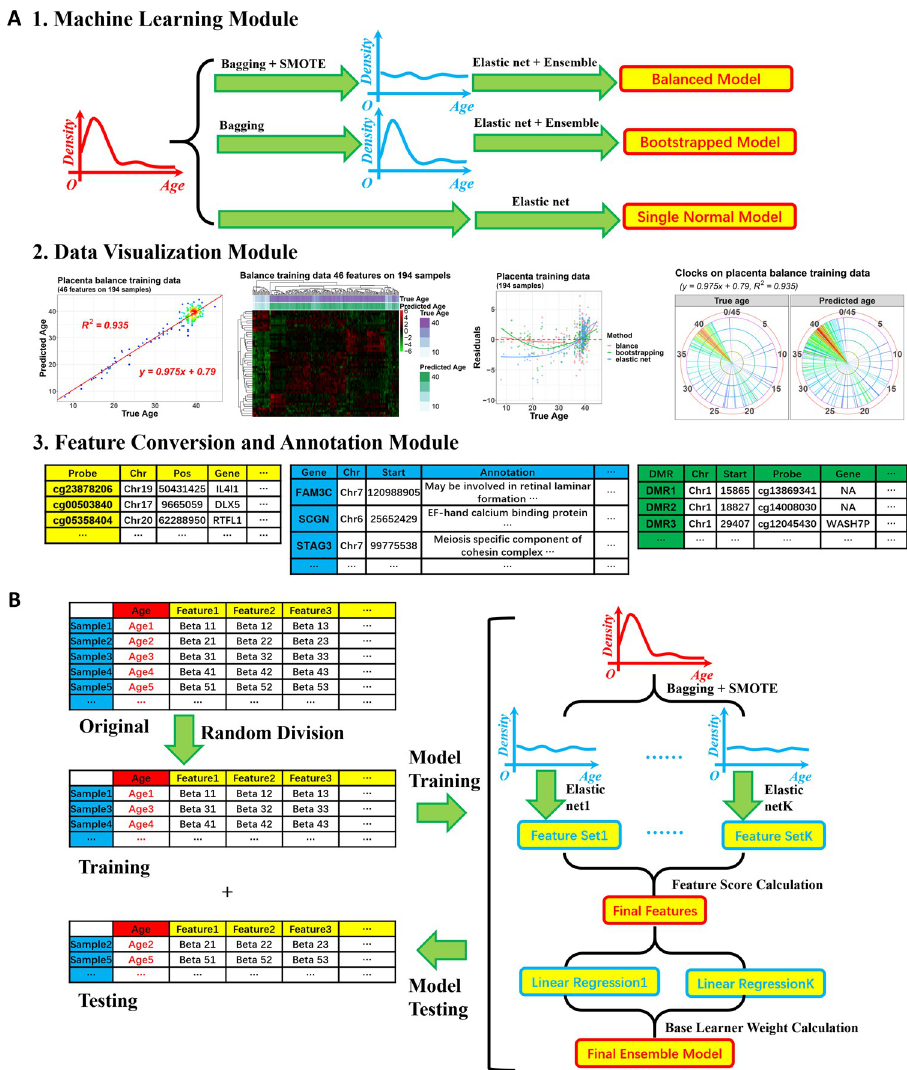
Fig 1. Package workflow. (A) The package has three modules: the machine learning module, the data visualization module, and the feature conversion and annotation module. (B) Workflow of the balanced clock model with several steps on data distribution adjustment (bagging coupled with SMOTE), elastic net base learner training, selected feature integration, linear regression base leaner training, and base learner